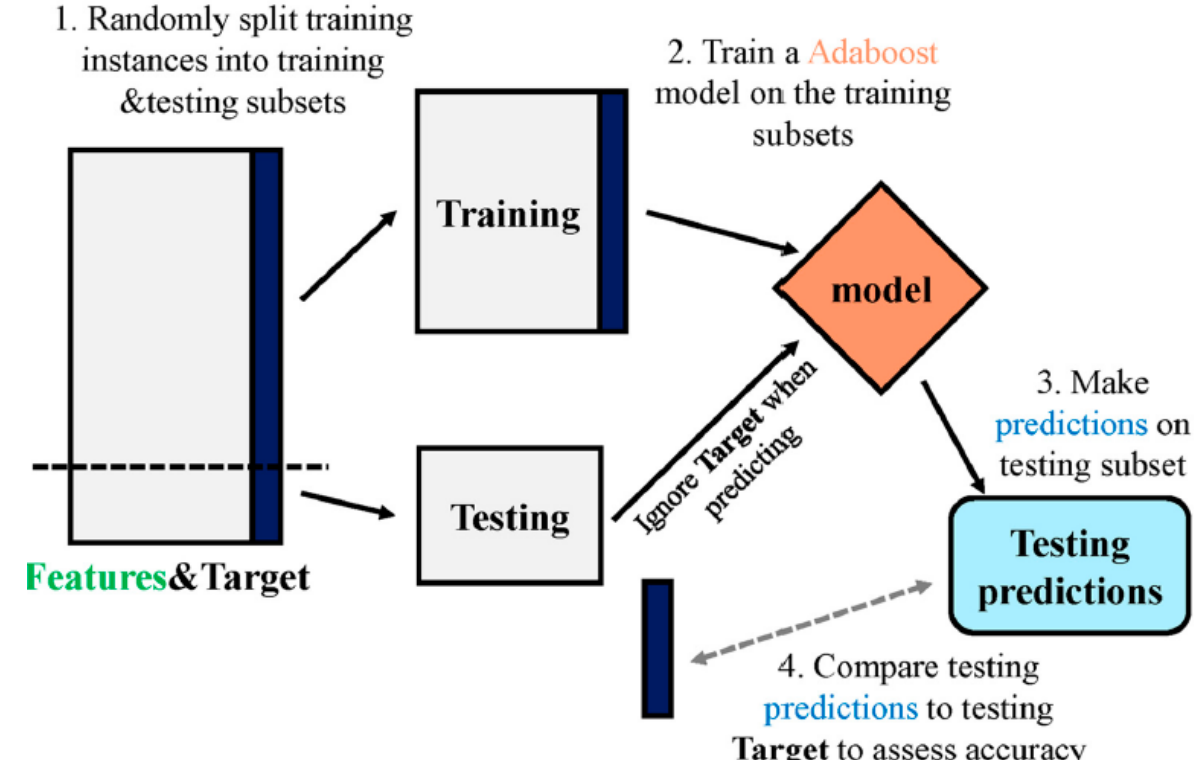
Figure 6. Schematic interpretation of AdaBoost regressor model [83] .